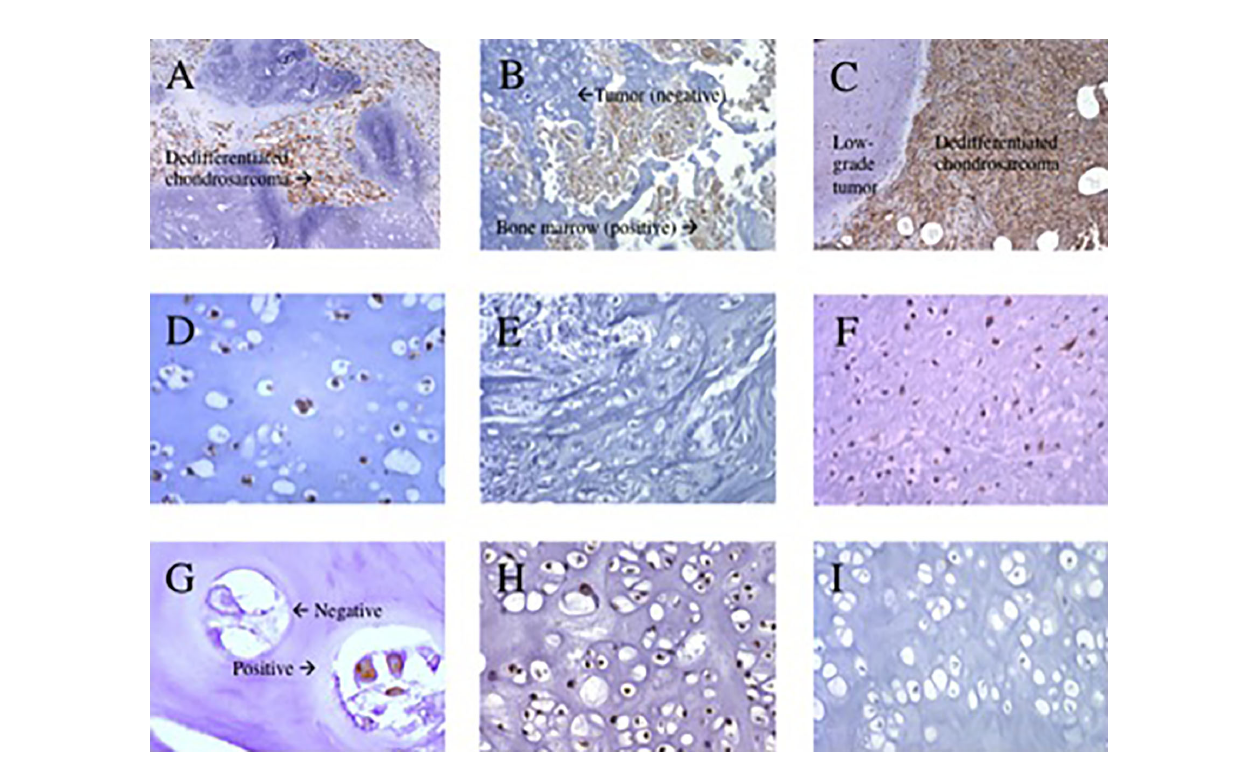
FIGURE 2 | Representative immunohistochemical staining patterns of primary chondrosarcoma tumors with HLA class I subunit speci fi c monoclonal antibodies. (A) HLA-A positive stain in dedifferentiated chondrosarcoma (100x magni fi cation). (B) HLA-A negative stain in grade 1 chondrosarcoma with positive bone marrow (200x magni fi cation). (C) HLA-B, -C positive stain in dedifferentiated chondrosarcoma (100x magni fi cation). (D) HLA-B, -C positive stain in grade 2 chondrosarcoma (400x magni fi cation). (E) HLA-B, -C negative stain in grade 3 chondrosarcoma (200x magni fi cation). (F) ; HLA-B, -C positive stain in grade 3 chondrosarcoma (200x magni fi cation). (G) b 2m both a positive and negative stain in grade 1 chondrosarcoma (400x magni fi cation). (H) b 2m positive stain in grade 2 chondrosarcoma (200x magni fi cation). (I) b 2m negative stain in grade 2 chondrosarcoma (200x magni fi